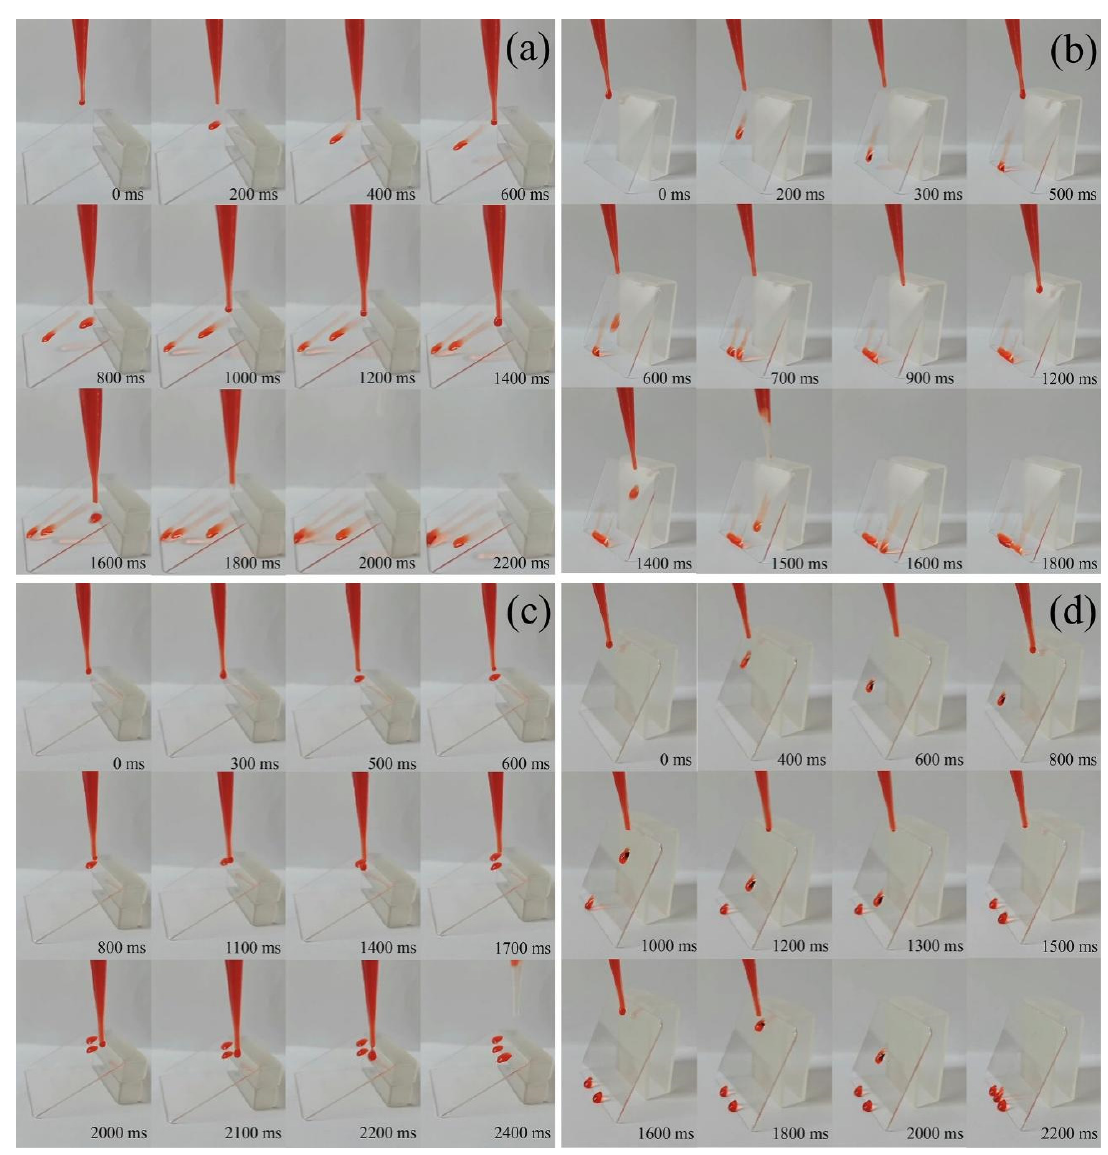
Figure 11. Time-sequence photographs of water droplets sliding process on the surfaces of the ( a , b ) calcined TiO 2 films and ( c , d ) calcined keratinchar-TiO 2 composite films at different sliding angles.